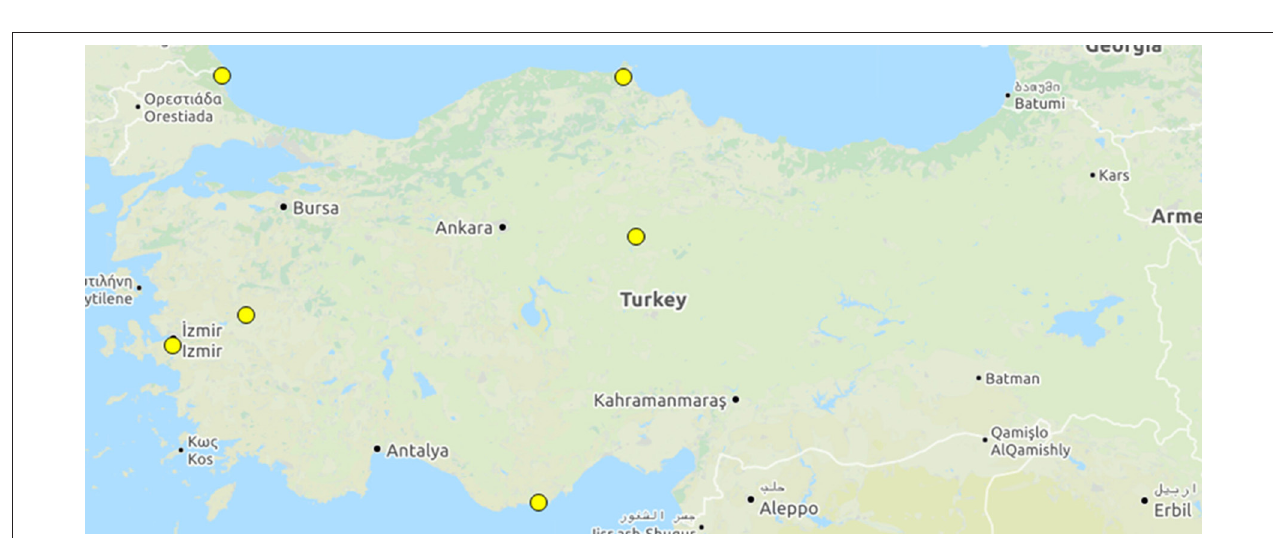
FIGURE 10 | Environmental conflicts against renewables , Turkish Map of Environmental Justice, March 2017 .